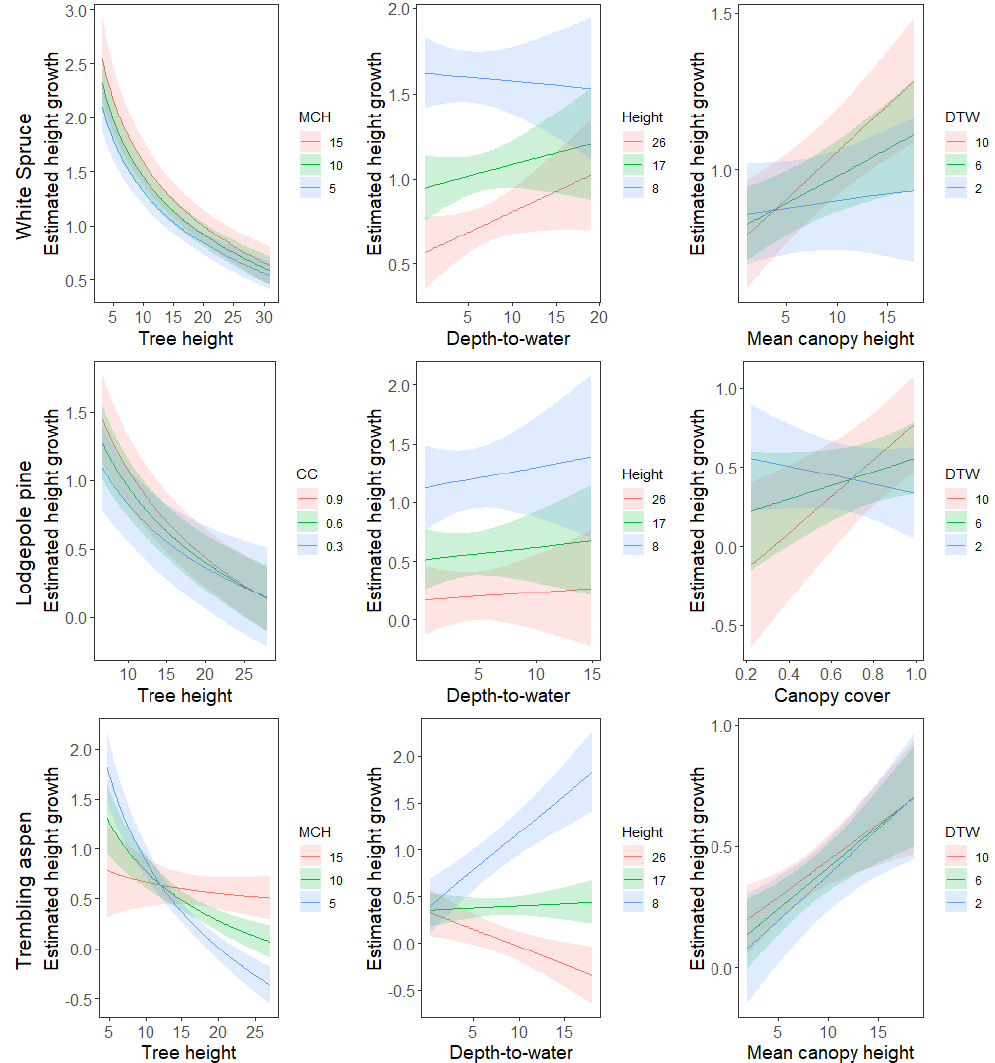
Figure 7. Posterior mean predictions (±1 standard error) of height growth by species, tree height (height), depth-to-water (DTW), and neighbourhood crowding. Note that the axes have different scales across